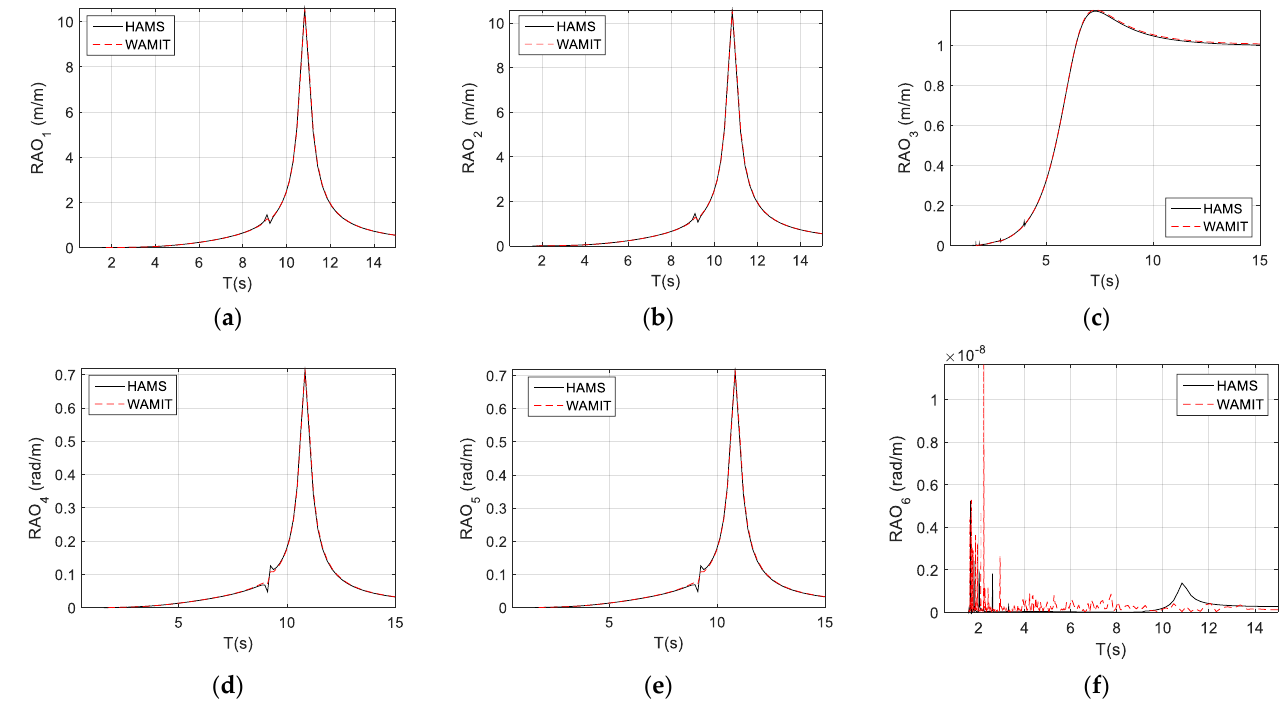
Figure 7. The responses of the TALOS motions in waves (wave angle = 45°). (a ) Surge; ( b ) sway; ( c ) heave; ( d ) roll; ( e ) pitch; and ( f ) yaw. ( c ) heave; ( d ) roll; ( e ) pitch; and ( f )